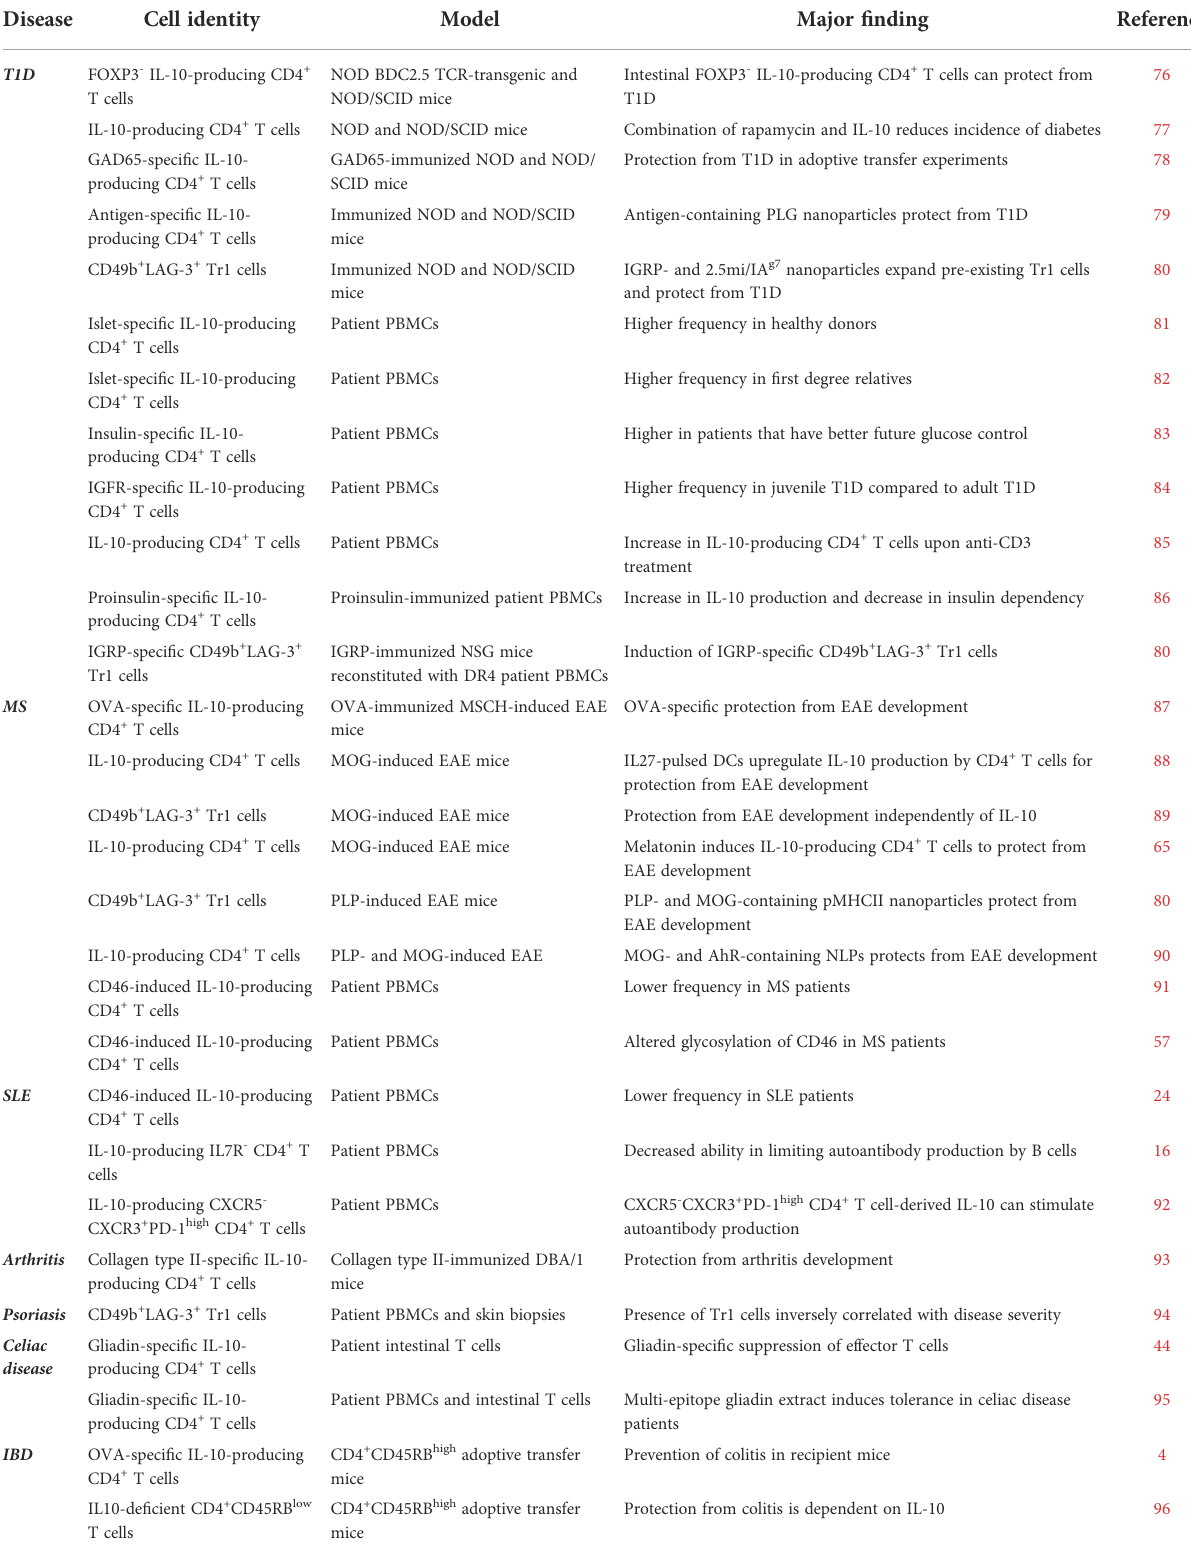
TABLE 1 Overview of the role of Tr1 and IL-10-producing CD4 + T cells in AIDs and